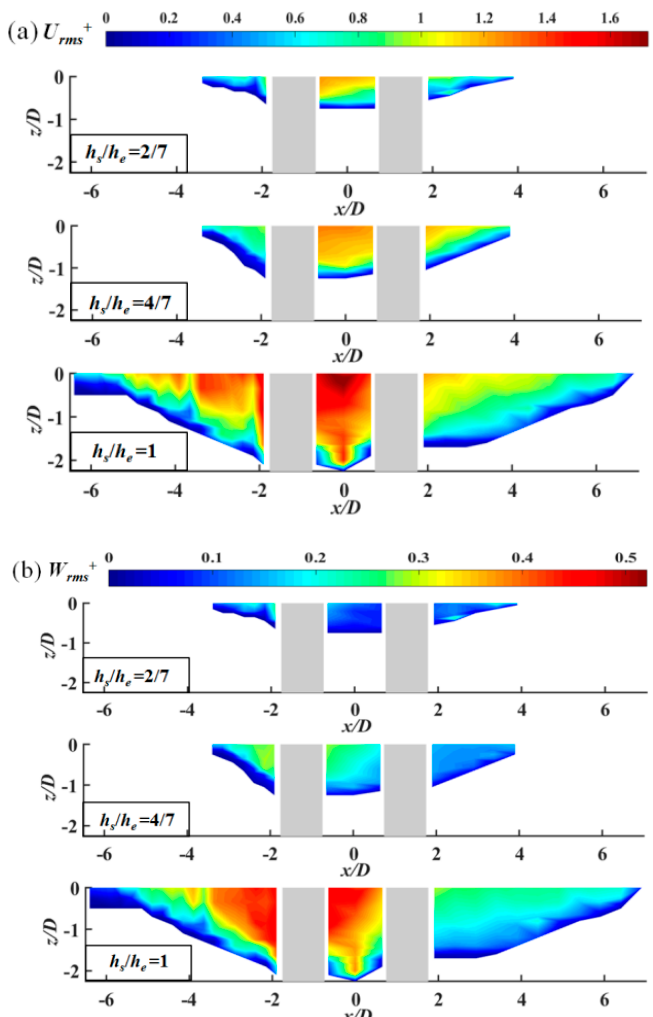
Figure 9. Contours of ( a ) u rms+ and ( b ) w rms+ in the symmetry plane for developing scour holes.